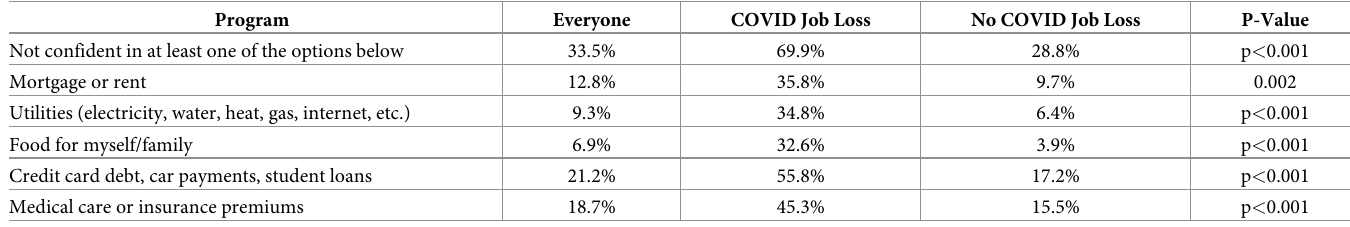
Table 6. Not confident in ability to pay for basic needs over next four